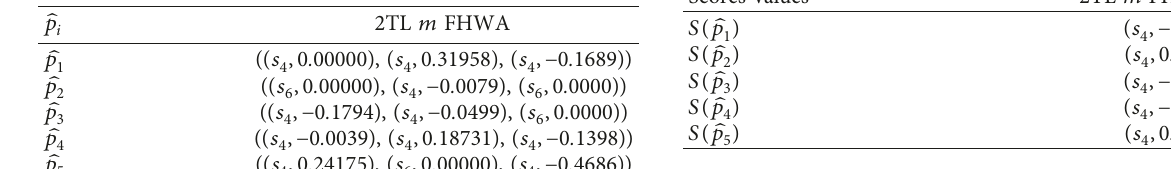
Table 3: Assembled assessment by using the 2TL m FHWA